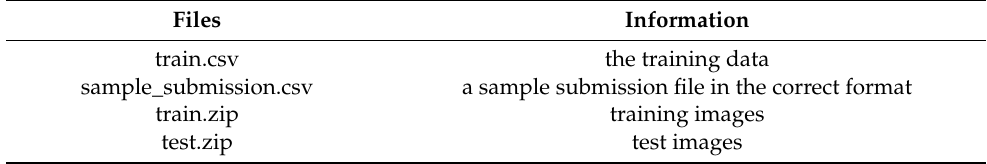
Table 1. The information of the data files in the Global WHEAT